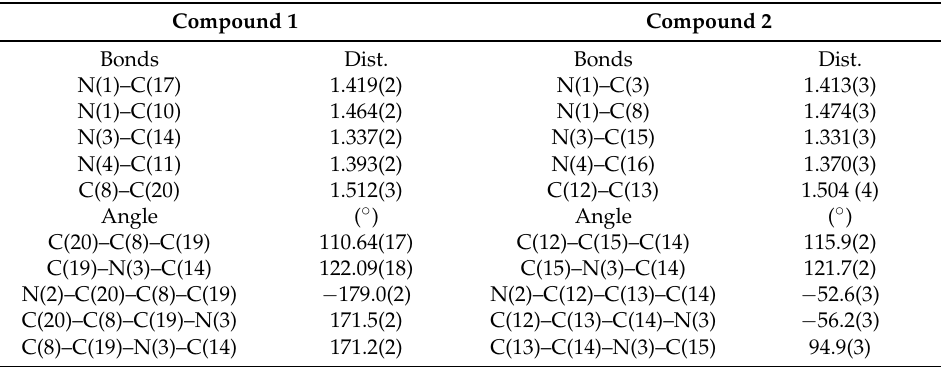
Table 3. Selected geometric parameters of compound 1 and 2 (Å, ˝ ).